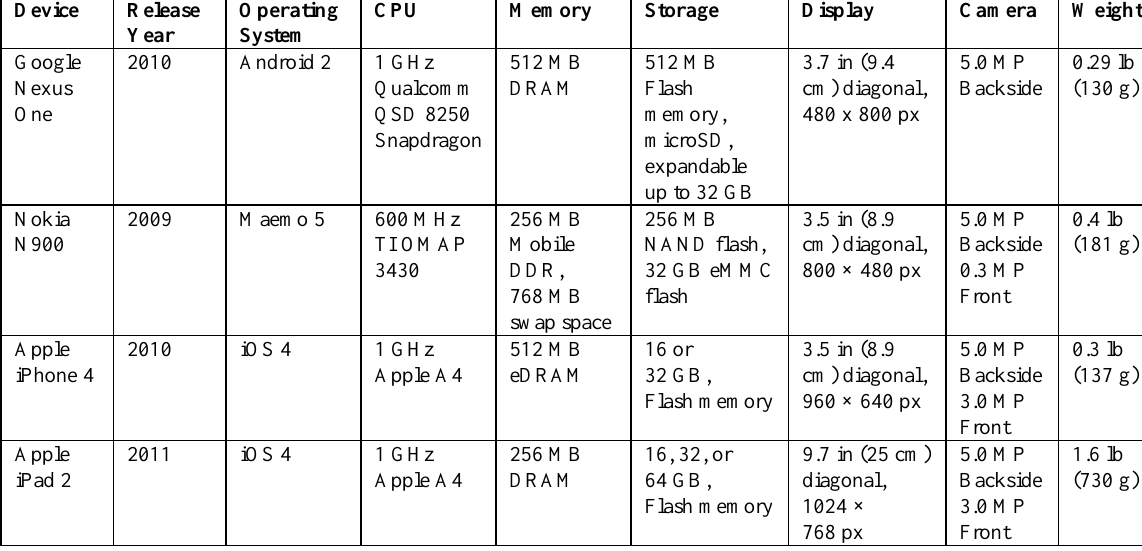
Table 1 Platform Comparison for the Google Nexus One, Nokia N900 and Apple